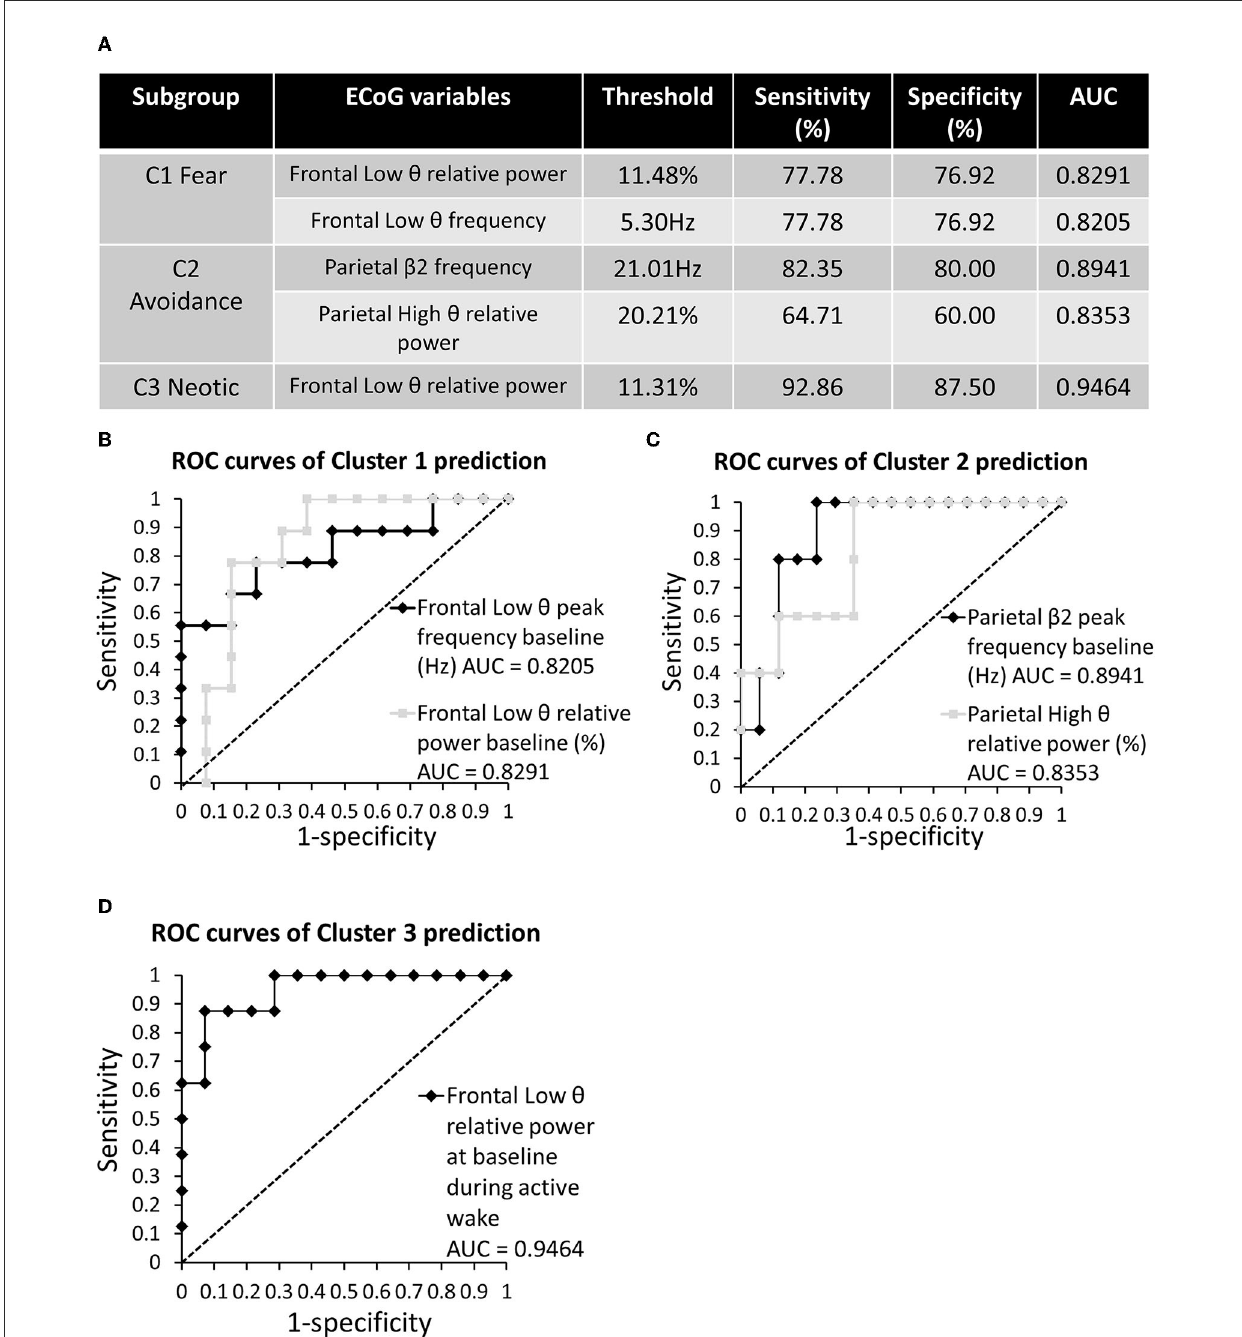
FIGURE8 ROC curves for cluster membership predicted using baseline EcoG. (A) Summary of ECoG variables predicting cluster membership with AUC > 0.8. (B) ROC curves for C1 (Fear) predictivity. (C) ROC curves for C2 (Avoidance) predictivity. (D) ROC curves for C3 (Neotic)